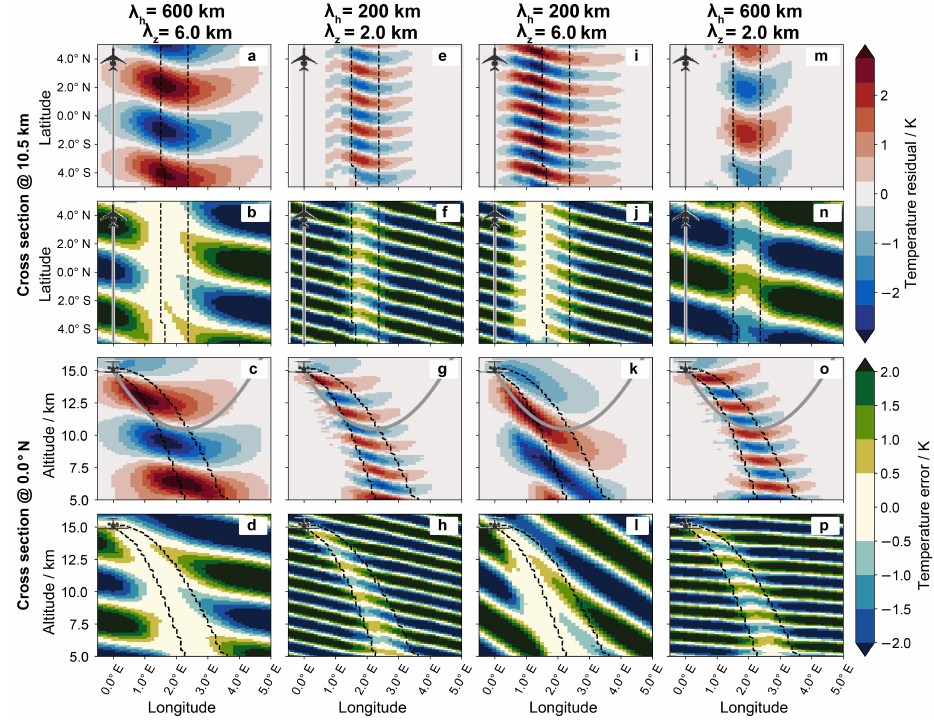
Figure 7. Cross sections of retrieved waves (first and third rows) and differences between synthetic and retrieved waves (second and forth rows) of the LAT retrieval. The different columns show waves with different horizontal ( λ h ) and vertical ( λ z ) wavelengths. The synthetic horizontal wave orientation of all waves is ϕ s = 210 ◦ and thus these waves are tilted towards the